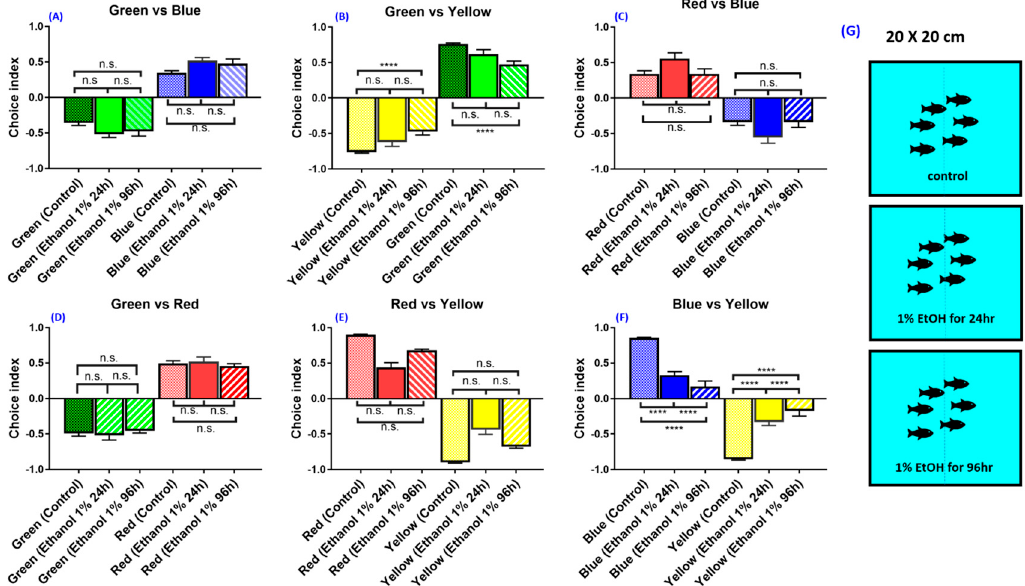
Figure 8. The e ff ect of 1% ethanol on wild-type zebrafish with the light source on top. The ethanol at 1% concentration was systematically administered to zebrafish and their color preference changes were chronologically measured at 24 and 96 h. ( A ) Green vs. blue combination, ( B ) green vs. yellow combination, ( C ) red vs. blue combination, ( D ) green vs. red combination, ( E ) red vs. yellow combination, ( F ) blue vs. yellow combination. ( G ) Schematics showing three settings with either control or 1% ethanol exposure for 24 h or 96 h. The data are presented as mean ± SEM, control ( n = 24); 1% ethanol, 24h ( n = 12); 1% ethanol, 96h ( n = 12). The di ff erence was tested by one-way ANOVA and the significance level was set at **** p < 0.0001. n.s. =